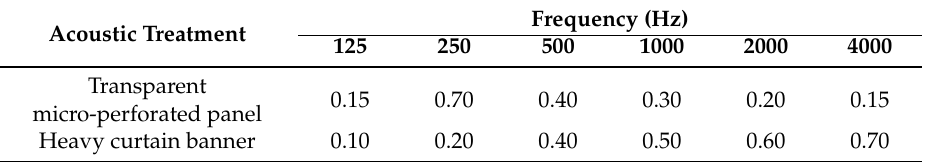
Table 2. Absorption coefficient of the acoustic treatments proposed in the Palatine